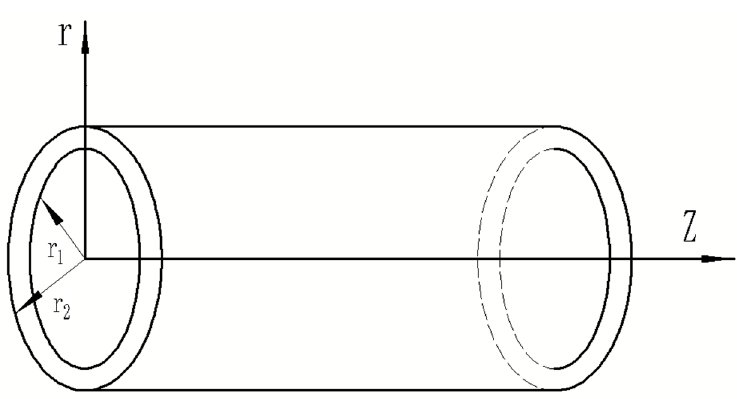
Figure 3. Simplified model of a single circular tube.